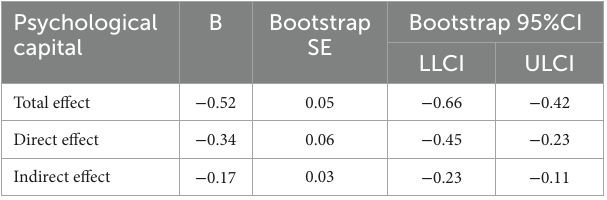
TABLE 4 Verifying the bootstrapping mediation effect ( n = 916, Shandong,